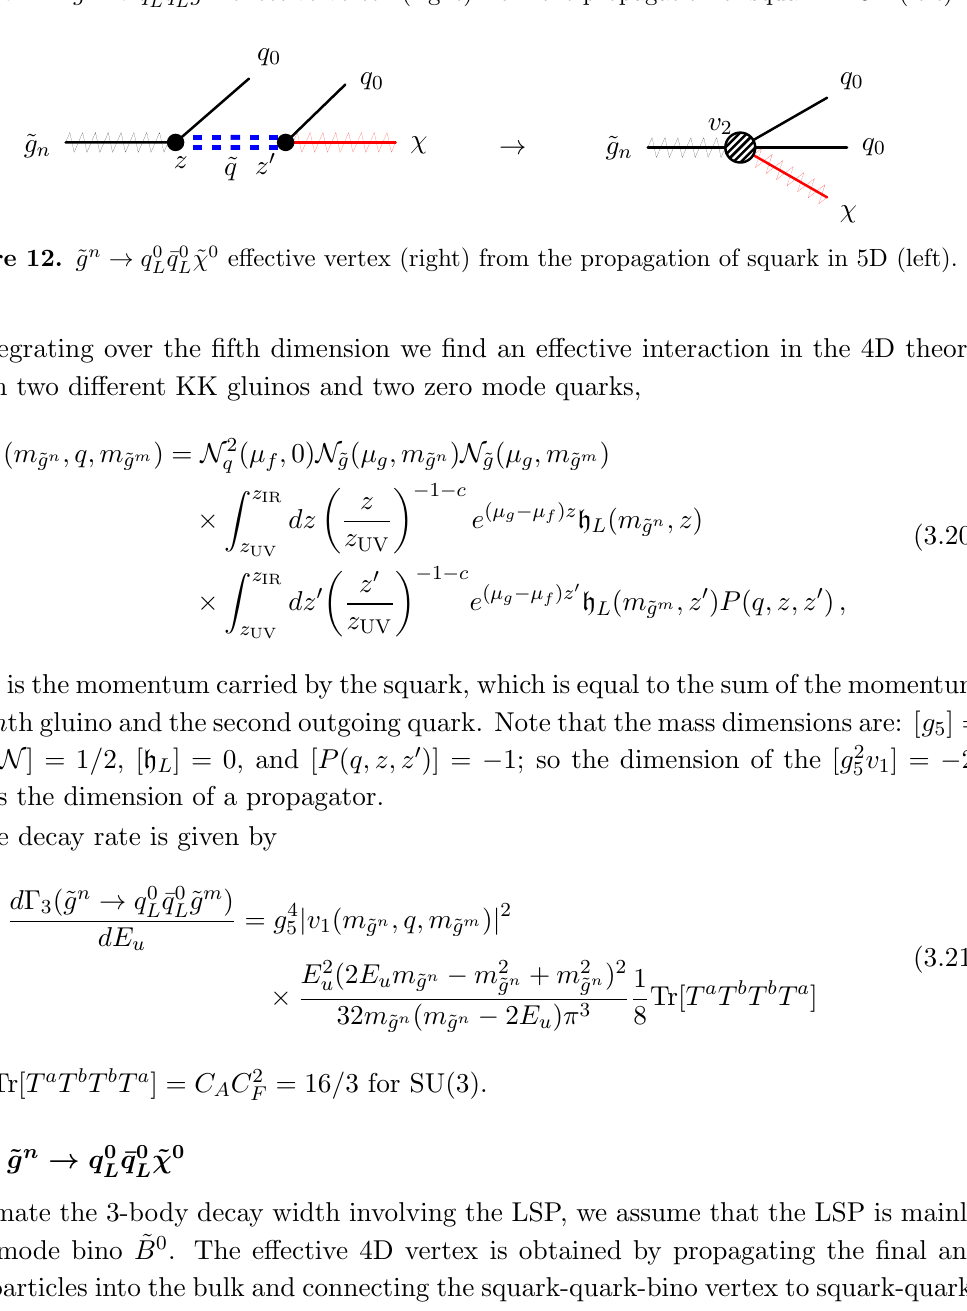
Figure 11. ~ g n ! q 0